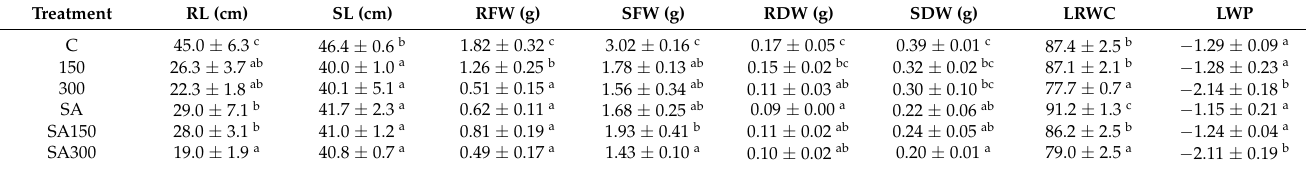
Table 1. Effect of salicylic acid (SA) pre-treatment on growth and physiological parameters (length, fresh weight, dry weight, leaf relative water content, and leaf water potential) of Hordeum vulgare L. ‘Ince-04 (cid:48) under saline conditions (150 and 300 mM NaCl). Values are mean ± SE ( n = 6). The data with different letters in the same column at superscript are significantly different ( p < 0.05).